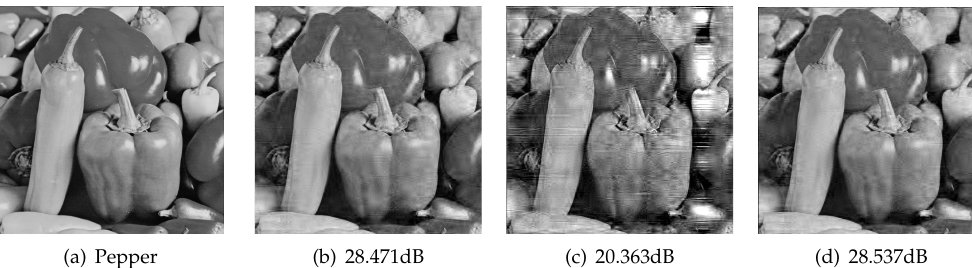
Figure 12. The reconstruction results of the standard test image Pepper at τ = 0.4. ( a ) original image; ( b ) reconstructed by HTP with α ∗ = 6, (PSNR: 28.471 dB); ( c ) reconstructed by CGIHT (PSNR: 20.363 dB); ( d ) reconstructed by CGHTP (PSNR: 28.537 dB).